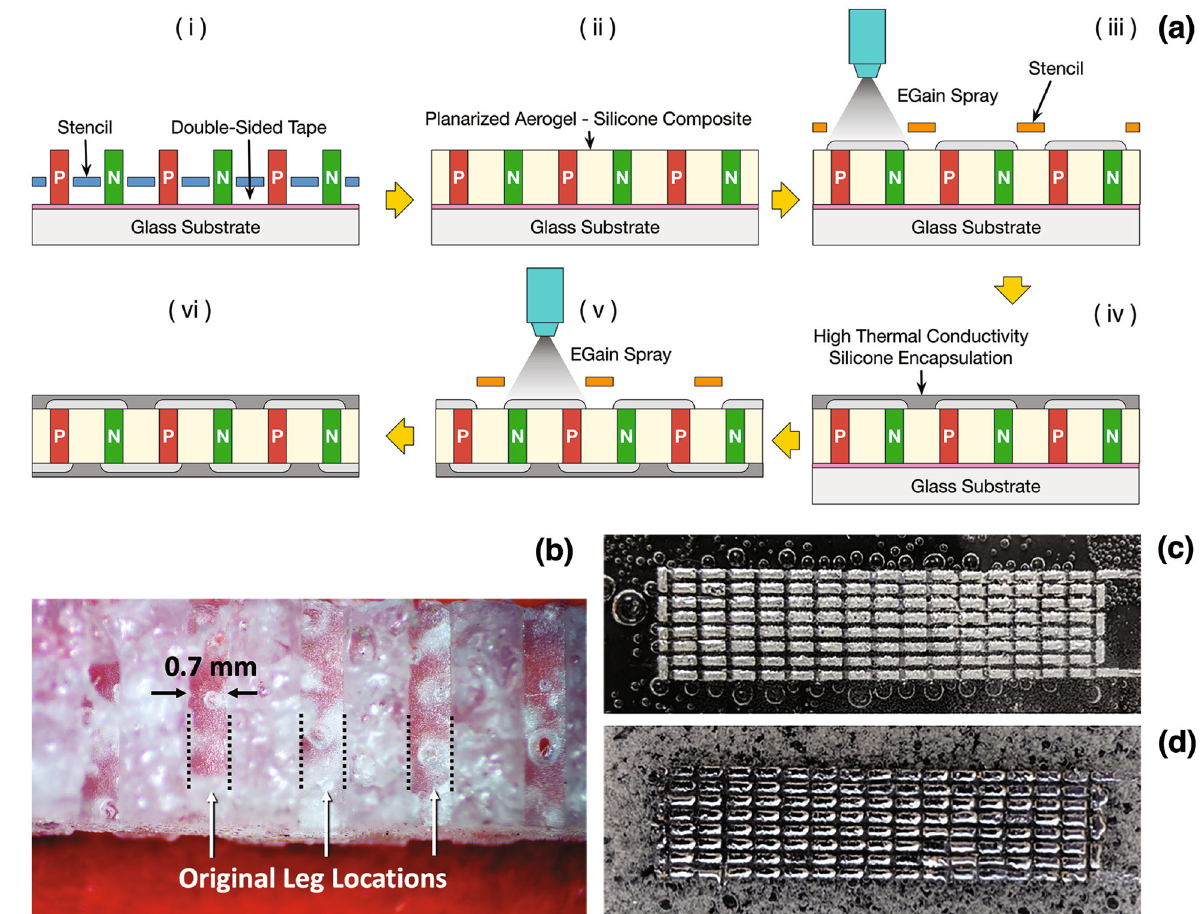
Fig. 9 Flexible TEG fabrication. a Process fl ow used to fabricate the fl exible TEGs. b A cross-sectional microscope image of a TEG captured after physically removing the legs. c Top-view of EGaIn interconnects on a module built using pure PDMS as the fi ller. d Top-view of EGaIn interconnects on a module built using the aerogel – silicone composite fi